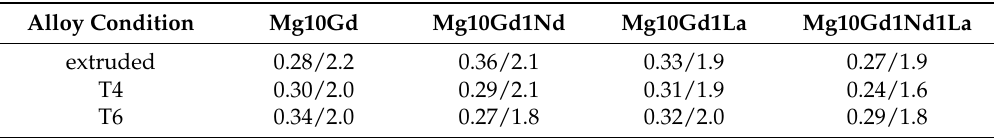
Table 4. Corrosion by polarization: deepest pit in mm/pitting